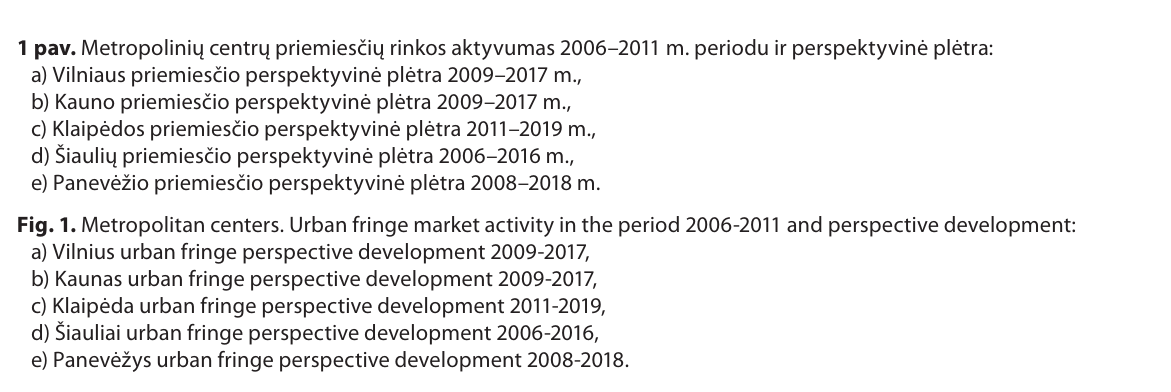
Fig. 1. Metropolitan centers. Urban fringe market activity in the period 2006-2011 and perspective